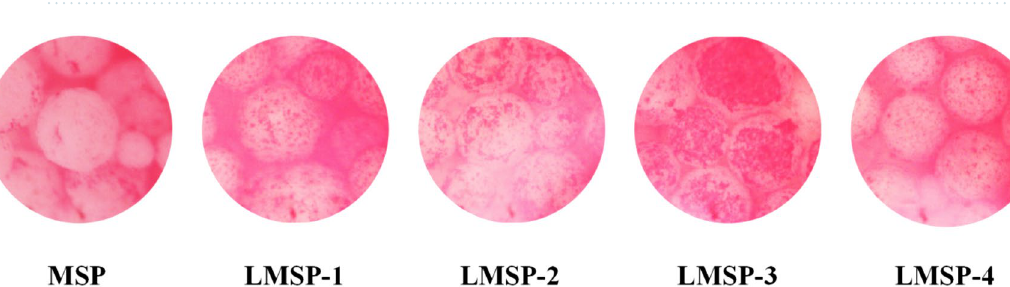
Figure 8. BMSCs cultured on MSP and LMSP-1–4 microsphere-based scaffolds for 10 days were stained with ALP staining Kit to evaluate the ALP secreted from cells.